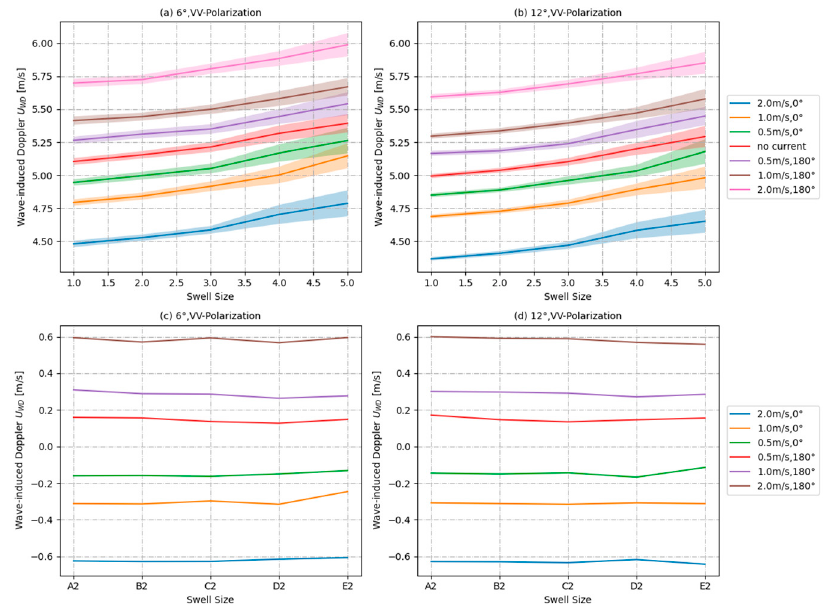
Figure 24. ( a , b ) show the variation in U WD with the scale of the swell when there is 10 m/s wind speed and swell in the same direction as the wind, with 0.5, 1, and 2 m/s surface currents in the downwind and upwind directions, respectively, with radar incidence angles of 6 ◦ and 12 ◦ . The colored solid lines indicate U WD , and the corresponding colored shading is 0.3 times the standard deviation. ( c , d ) correspond to ( a , b ), indicating the difference between the U WD of the presence and absence of